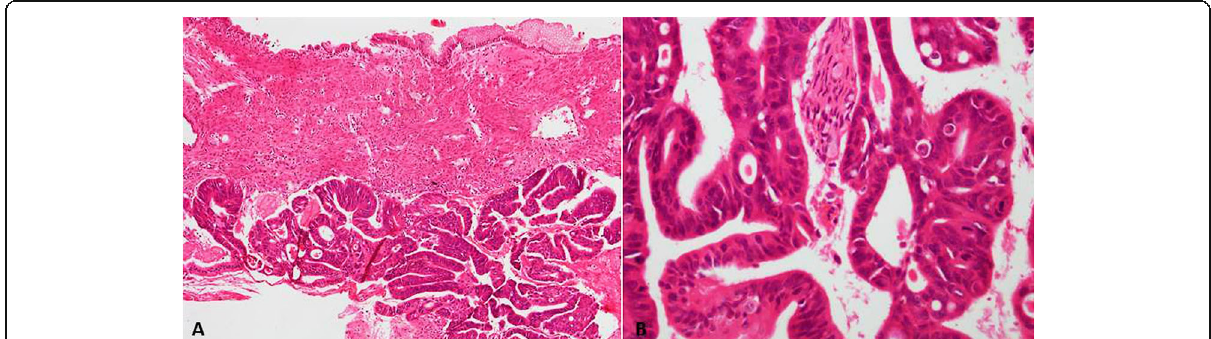
Fig. 4 a , b Mucinous cystic neoplasm with high grade dysplasia. The neoplasm shows both conventional tall columnar lining at top ( a ) and high